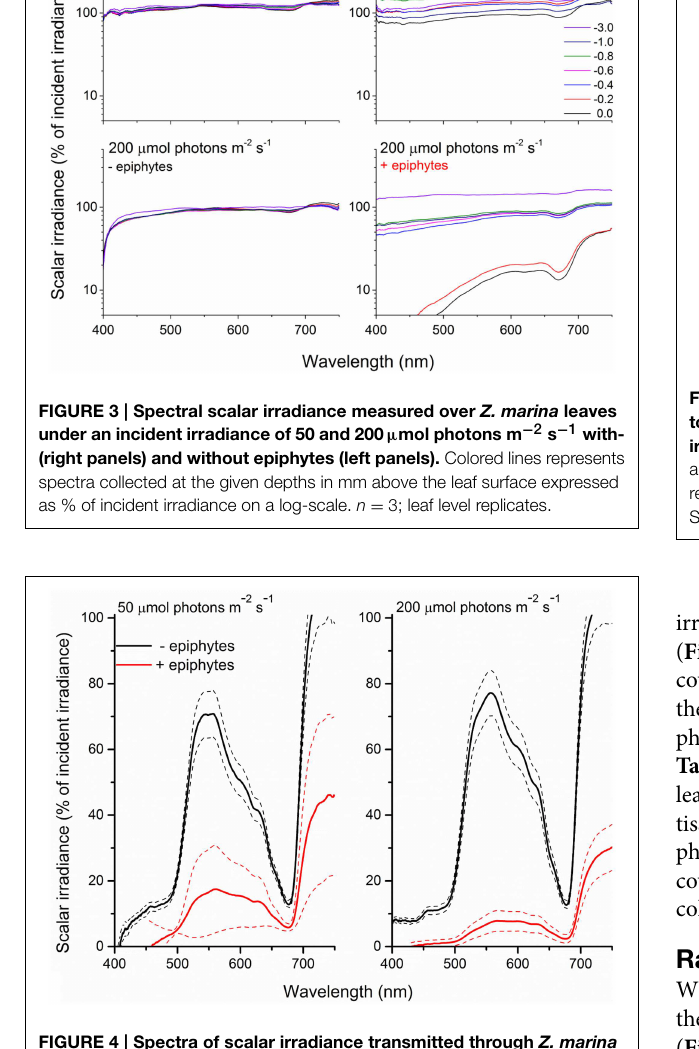
FIGURE 4 | Spectra of scalar irradiance transmitted through Z. marina leaves with- (red line) and without (black line) epiphyte cover and at two different downwelling photon irradiances (50- and 200- µ mol photons m − 2 s − 1 ). Dashed lines represents ± S.D. n = 4 ; leaf level replicates.